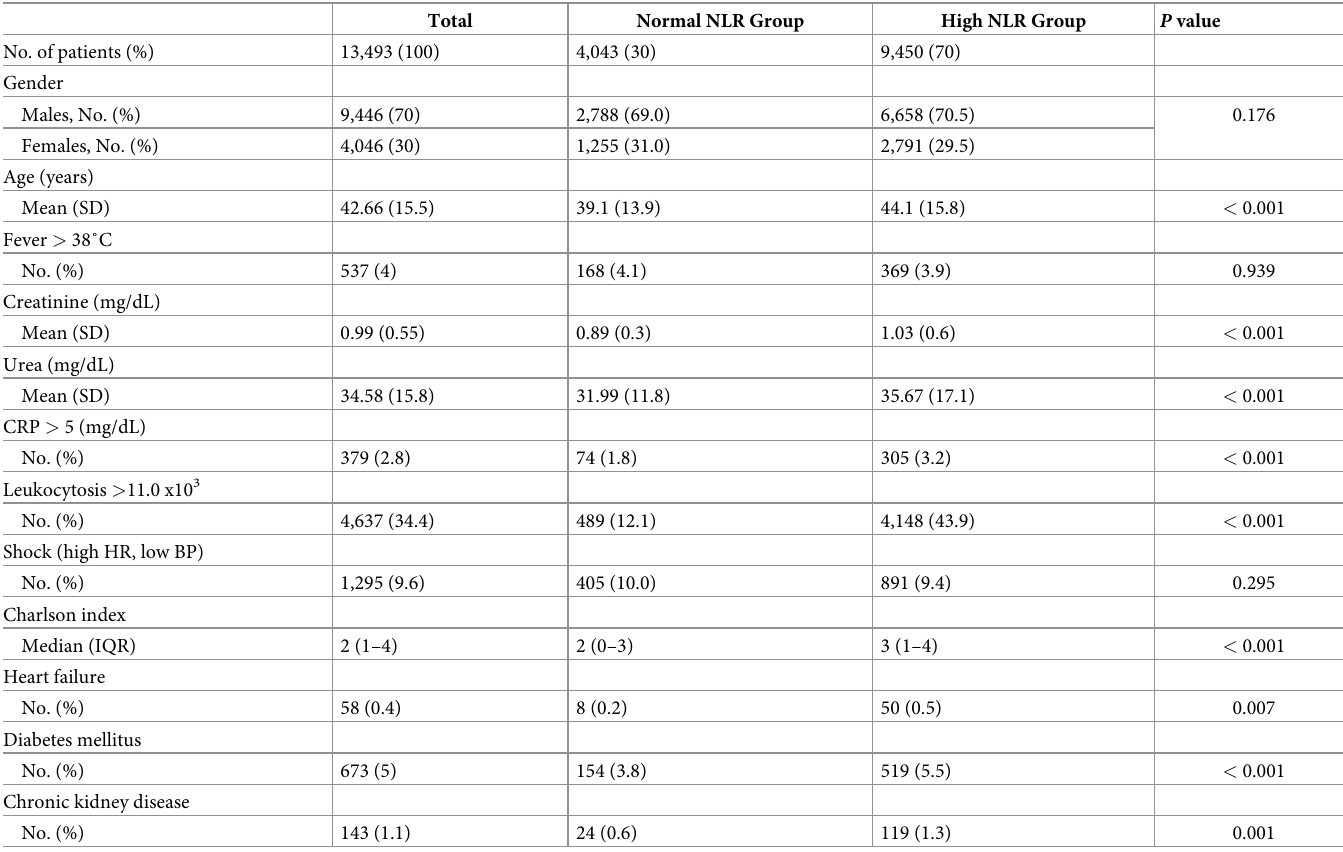
Table 1. Demographic and clinical characteristics of renal colic